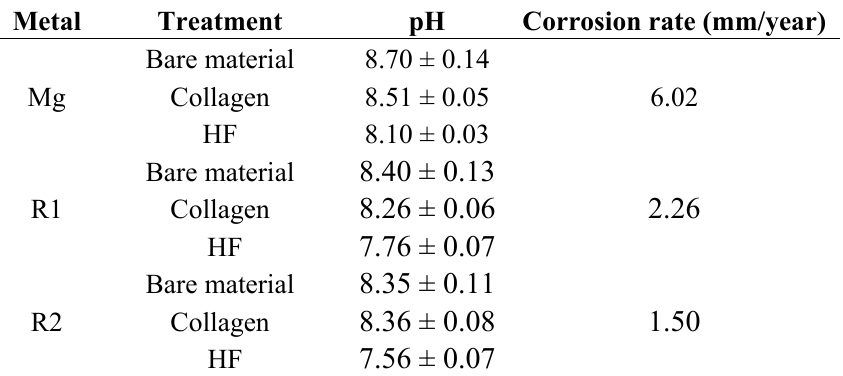
Table 1. Corrosion rate and pH of culture media after incubation with different materials for 3 days.